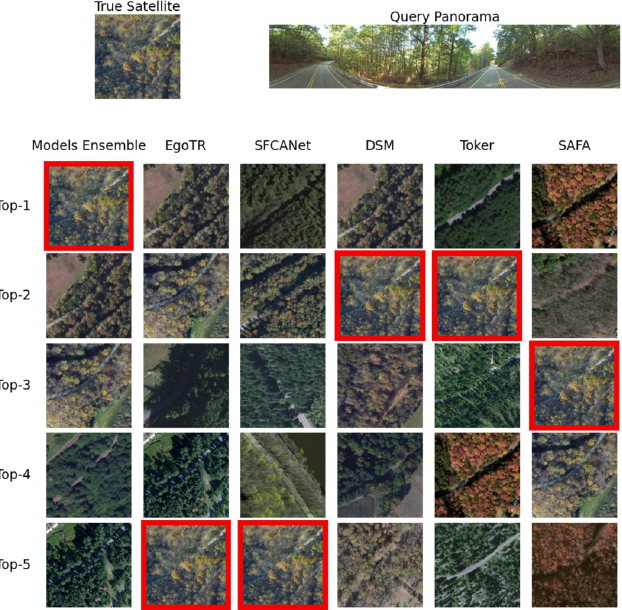
Fig 10. An example that shows the ensemble model r@(1—5) compared to the individual models on the CVUSA dataset. The true satellite has a red border.